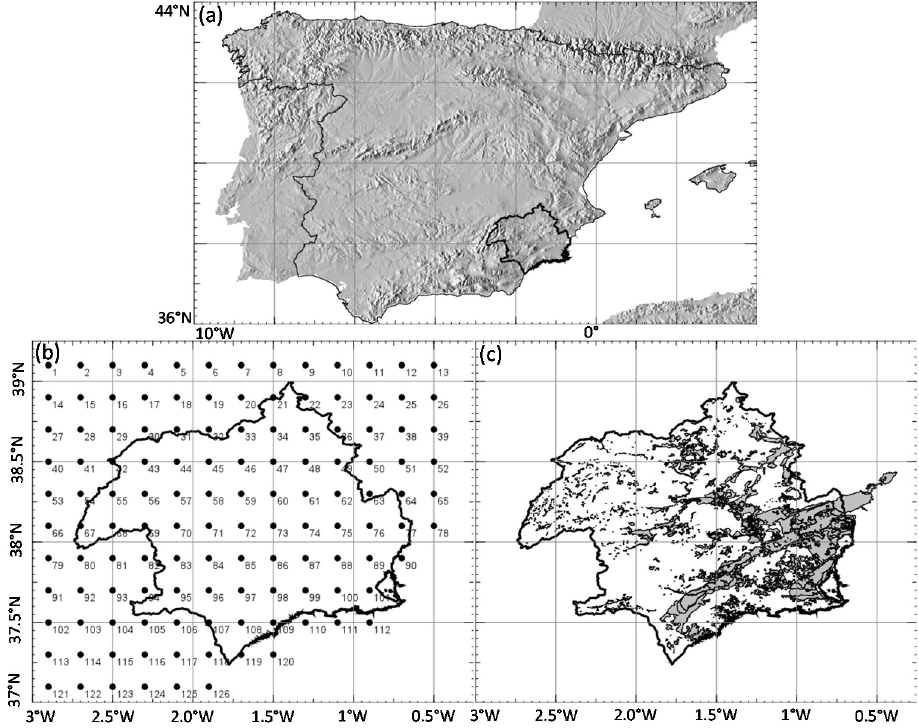
Figure 1. Study basin: ( a ) location of the SRB in the Iberian Peninsula; ( b ) grid-sites for analysis; and ( c ) irrigated